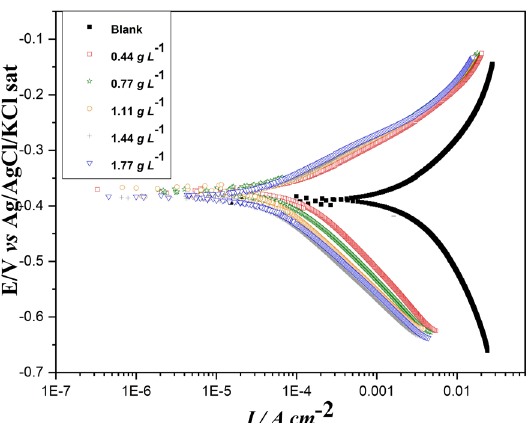
Figure 6. Tafel plot for SAE 1008 carbon steel in 0.5 mol L -1 HCl solution in the absence and presence of different concentrations of cocoa bean shell powder. Table 5. Polarization parameters for carbon steel in 0.5 mol L -1 HCl solution in the absence and presence of different concentrations of cocoa bean shell powder. Inhibitor concentration (g L -1